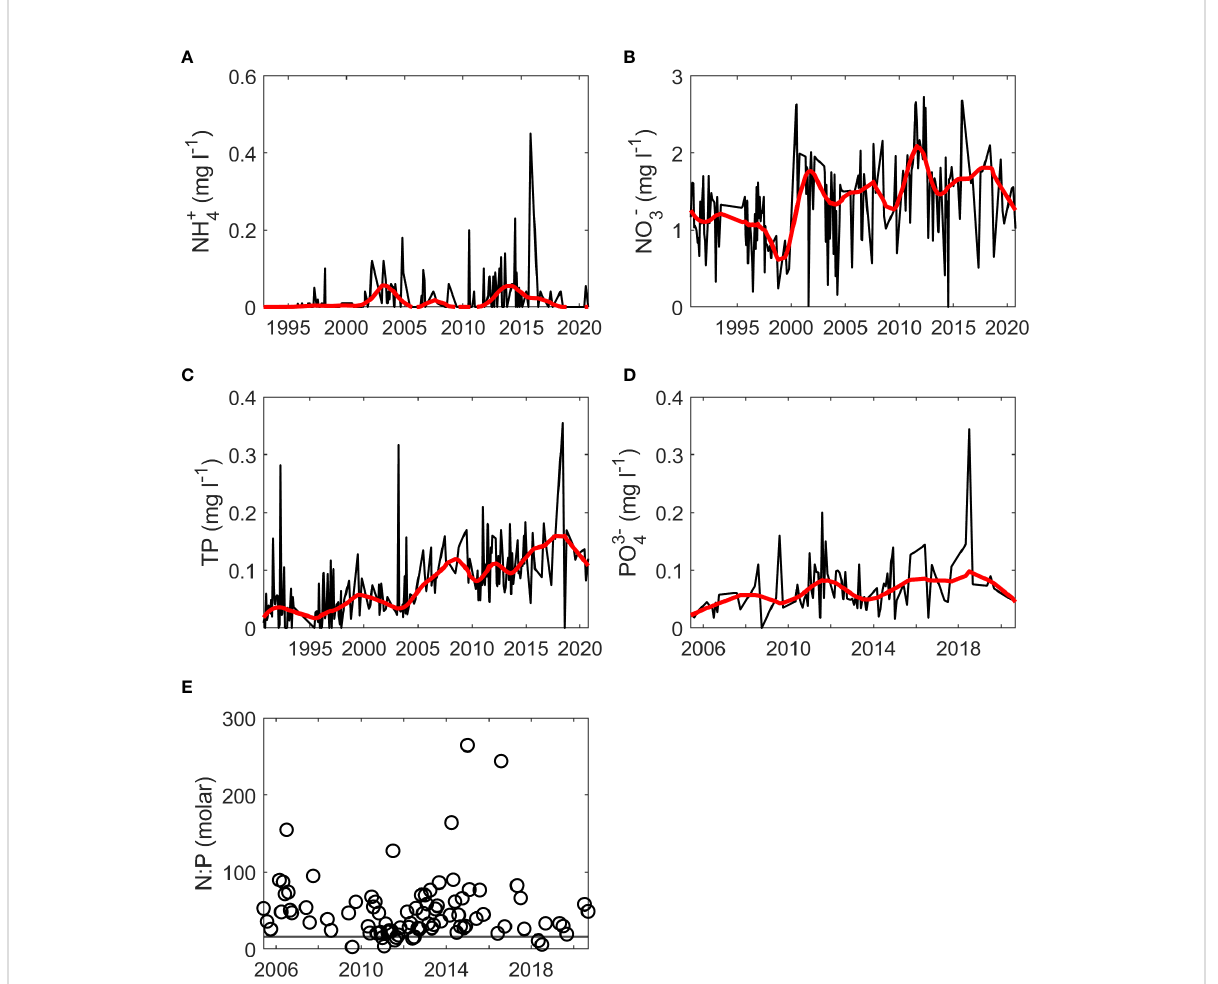
FIGURE 3 Monthly nutrient values (black) and fi tted rloess curves (red) at the gauge for (A) NH 4+ , (B) NO 3- , (C) TP, (D) PO 43- and (E) molar N:P ratio calculated as (NH 4+ +NO 3- ): PO 43- . The horizontal gray line in (E) represents the Red fi eld ratio. The start of time series for NH 4+ , NO 3- , and TP was 1990-1992 while the start of the time series for PO 43- was